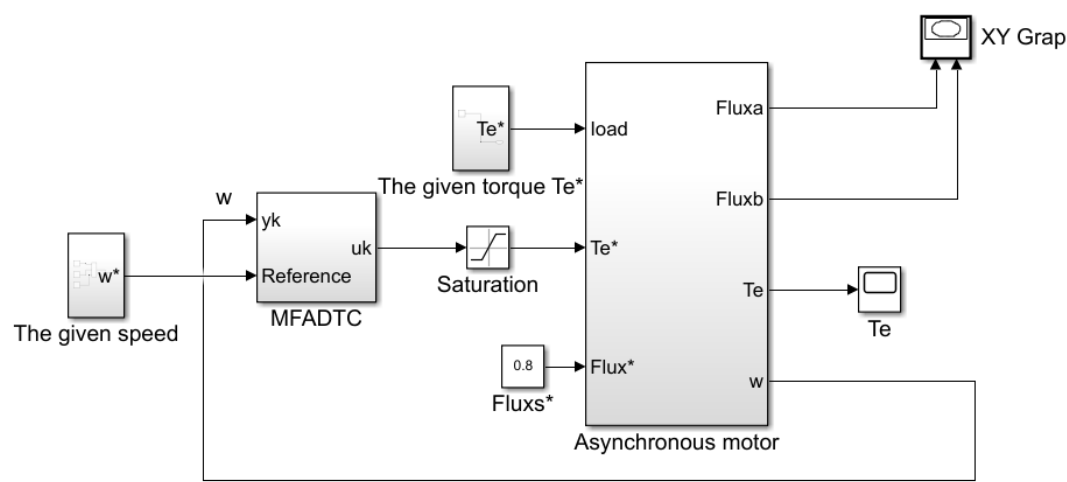
Figure 4. Simulation model of the asynchronous motor direct torque control system based on a model-free adaptive direct torque control (MFADTC).